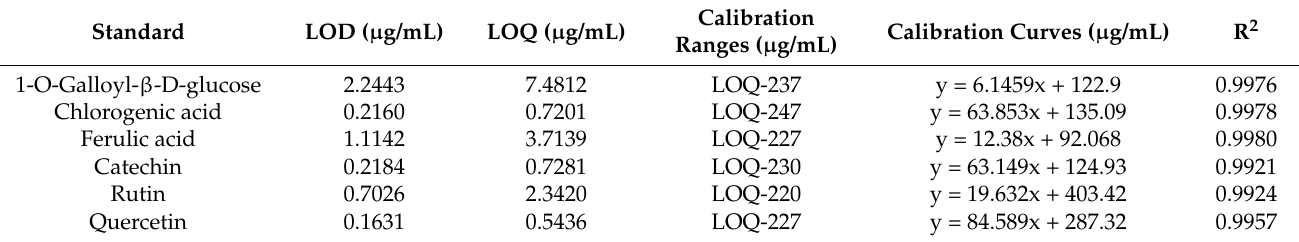
Table A1. Standard analytes used for elaborating the calibration curves with the range used, equa- tions, R 2 , LOD, and LOQ of each compound for the phenolic compound